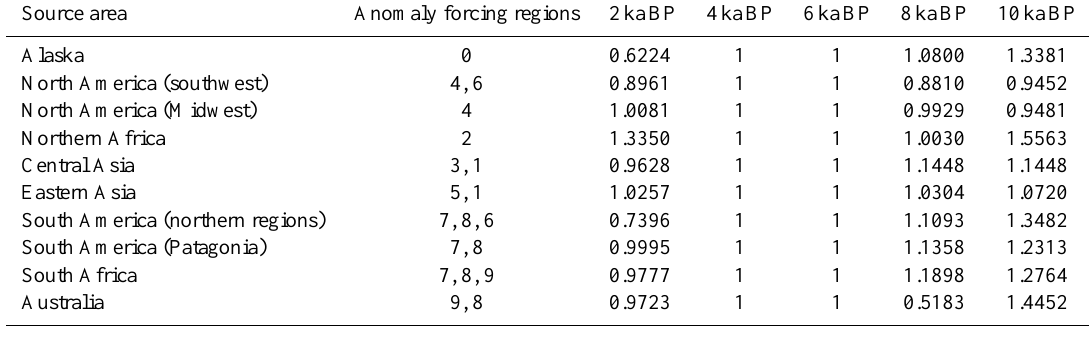
Table 2. Dust source areas in the CESM model and scale factors expressed as anomalies with respect to a reference period, derived from the observations. The first column lists the model dust source areas. The second column gives the geographical regions where observations are clustered; these are used to scale the dust from the corresponding model macro-areas. The reference periods are 4 for 2kaBP, and 6ka BP for 8 and 10kaBP.